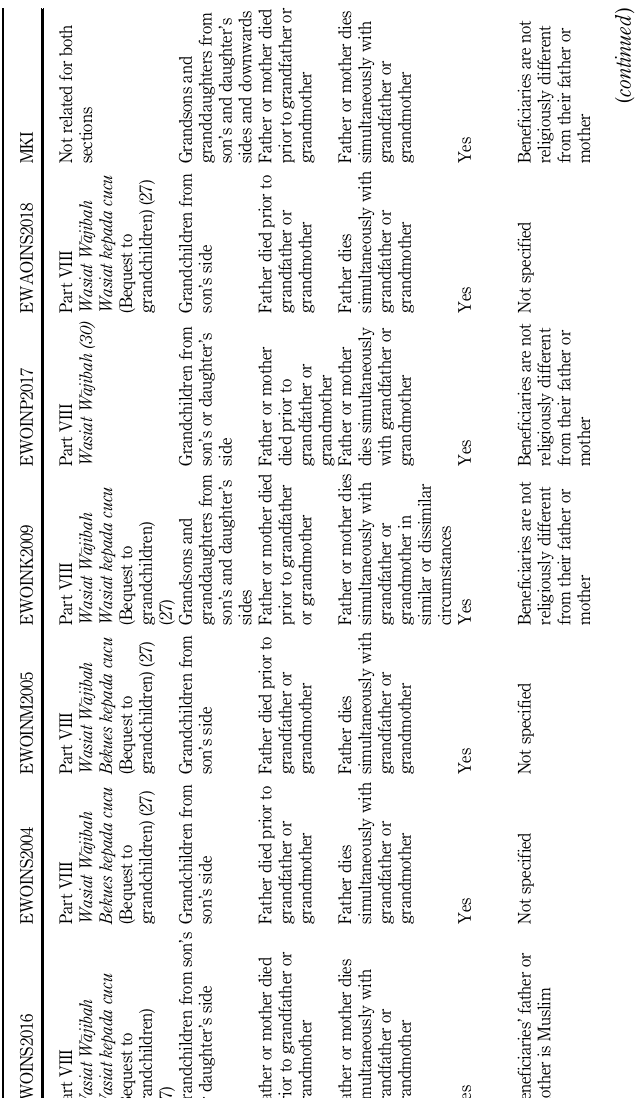
Table 1. Comparison